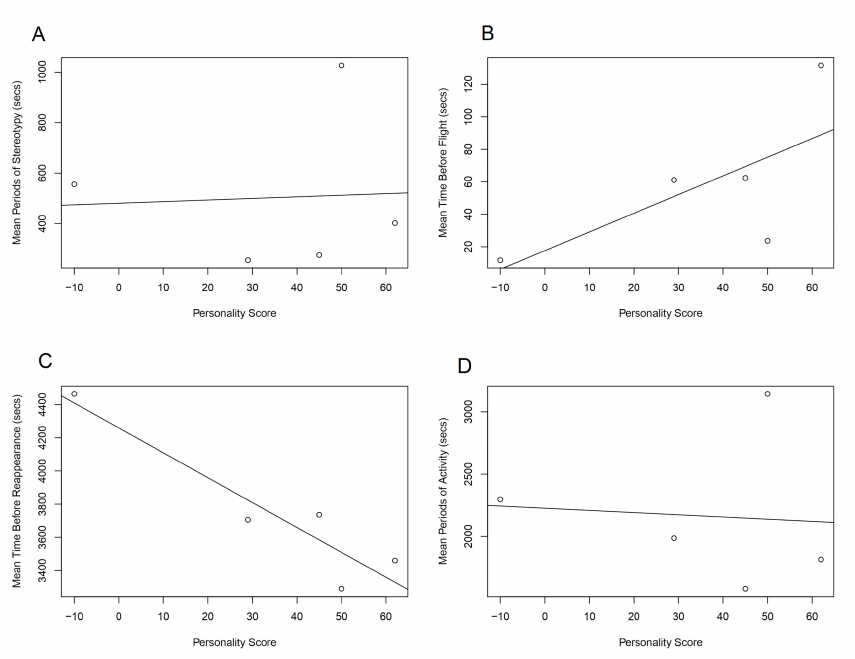
Figure 2. Linear regressions representing relationships between the mean expressions of key behaviours and personality scores, performed on a translocated group of red squirrels into the Braichmelyn forest, 2017: ( A ) Stereotypy(R 2 = − 0.3292, n / df = 5 , p = 0.9292), ( B ) flight (R 2 = 0.2929, n / df = 5, p = 0.2016), ( C ) reappearance (R 2 = 0.8258, n / df = 5, p = 0.0209), and ( D ) activity (R 2 = -0.3246, n / df = 5, p =